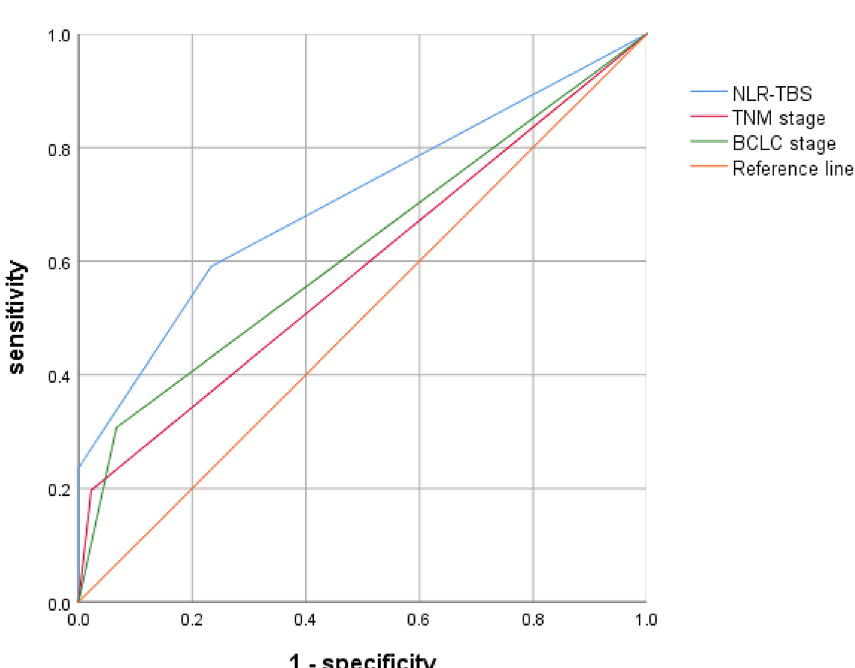
Figure 5. Comparison of NLR–TBS group, TNM stage and BCLC stage in predicting